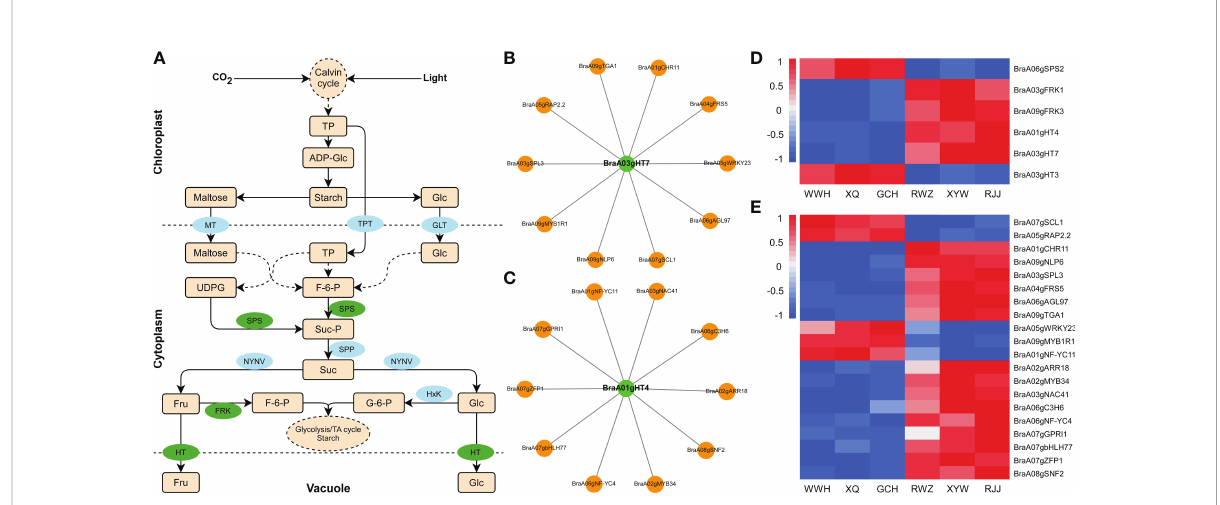
FIGURE 4 Pathway related to soluble sugar biosynthesis in Chinese cabbage. (A) Reconstruction of the soluble sugar biosynthetic pathway with the differentially expressed structural genes. Green ellipses represent essential genes we identi fi ed by RNA-Seq, and blue ellipses represent the genes involved in the glucosinolate biosynthesis. (B) Heatmap of the DEGs involved in soluble sugar biosynthetic pathway. (C) Correlation network of essential gene and transcription factors in the blue module. (D) Correlation network of structural genes and transcription factors in the green module. Green circles represent structural genes, and orange circles represent TFs. (E) The expression of transcription factors involved in soluble sugar biosynthesis in RNA-Seq